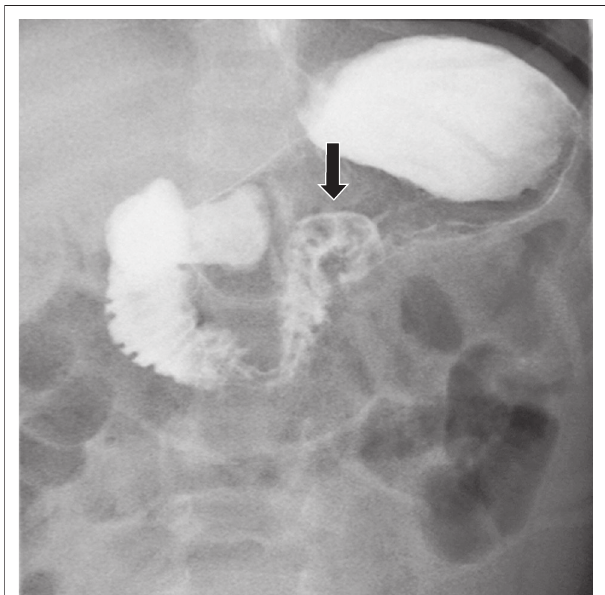
FIGURE 1: Normal upper gastrointestinal series in an infant with vomiting. Fluoroscopic frontal view shows the duodenojejunal junction (arrow) to the left of a vertebral body pedicle and at the level of the duodenal